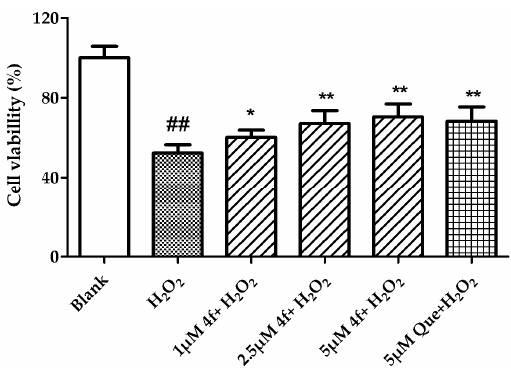
Figure 4. Neuroprotective activity of compound 4f against H 2 O 2 -induced cell death in PC12 cells. ( ## P < 0.01 vs. Blank group. * P < 0.05 and ** P < 0.01 vs. H 2 O 2 -treated group.).